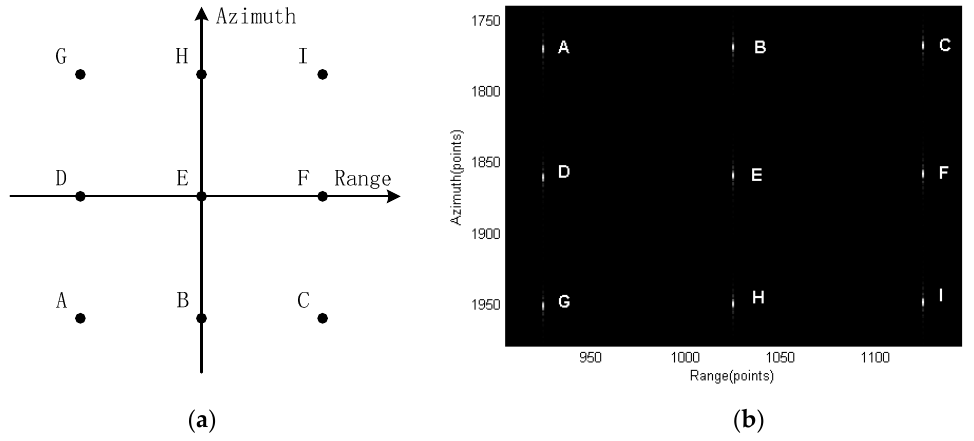
Figure 6. Nine targets in the scene: ( a ) targets position and ( b ) the targets images using the proposed signal model and RMA.